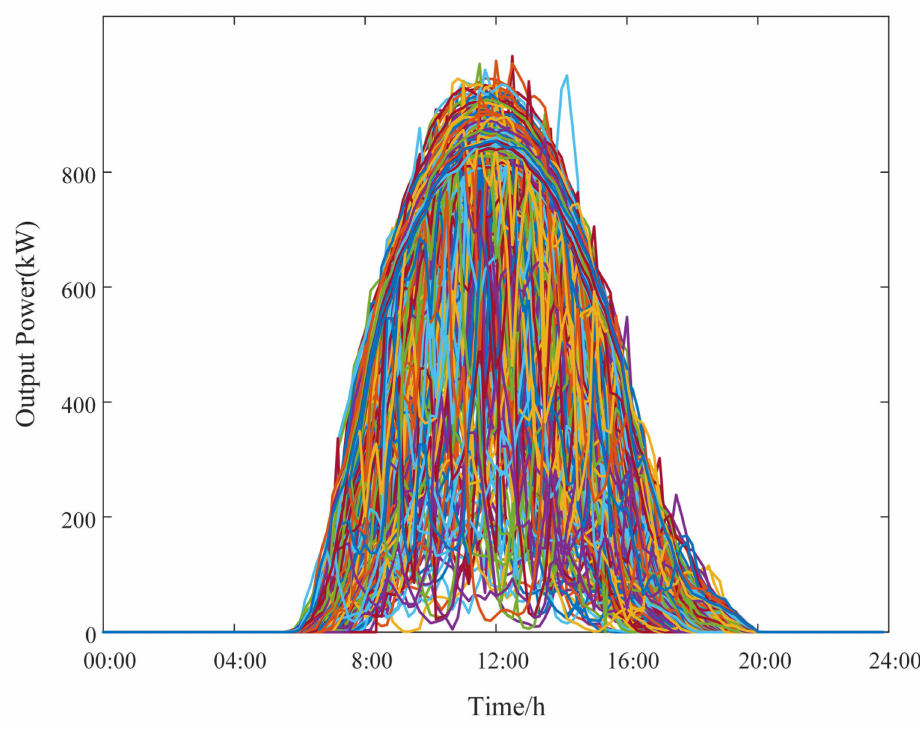
Figure 1. Annual daily output curve of photovoltaic power plants.